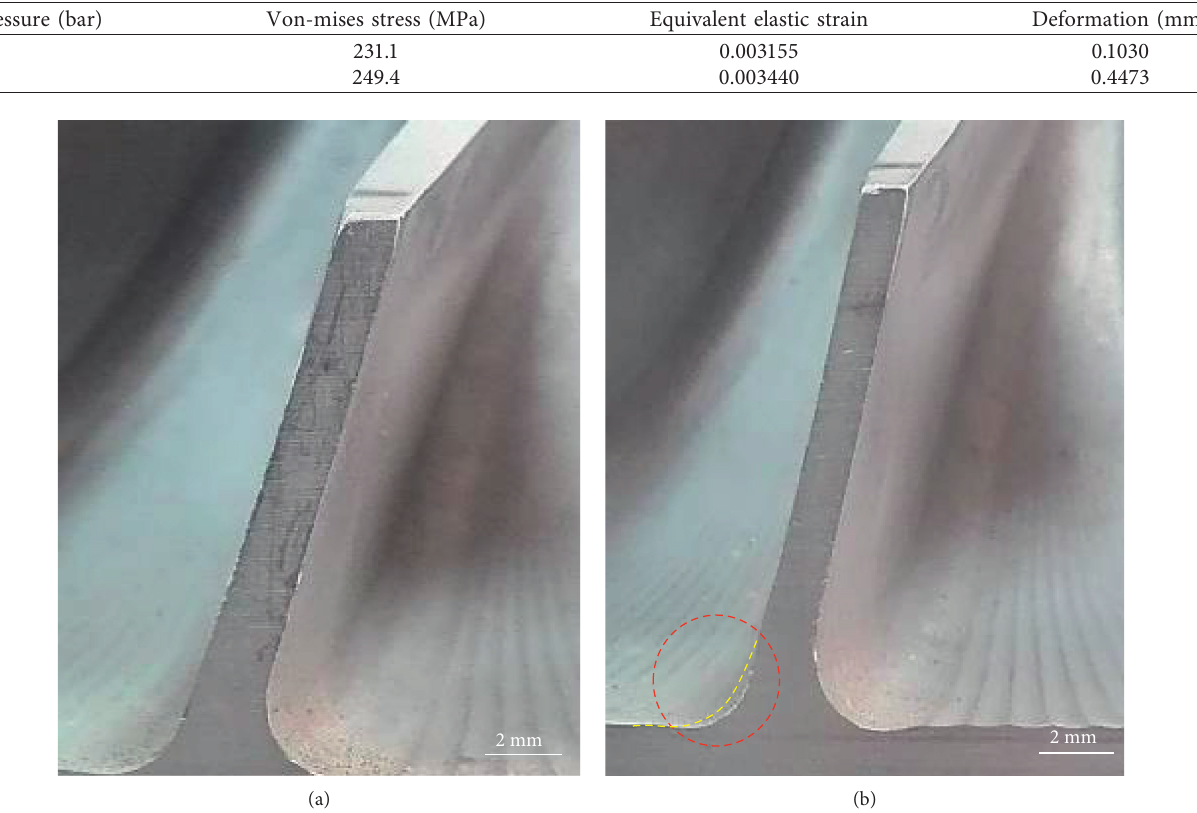
Table 8: Compered FEM results between pressure difference 0.1 and 0.5.